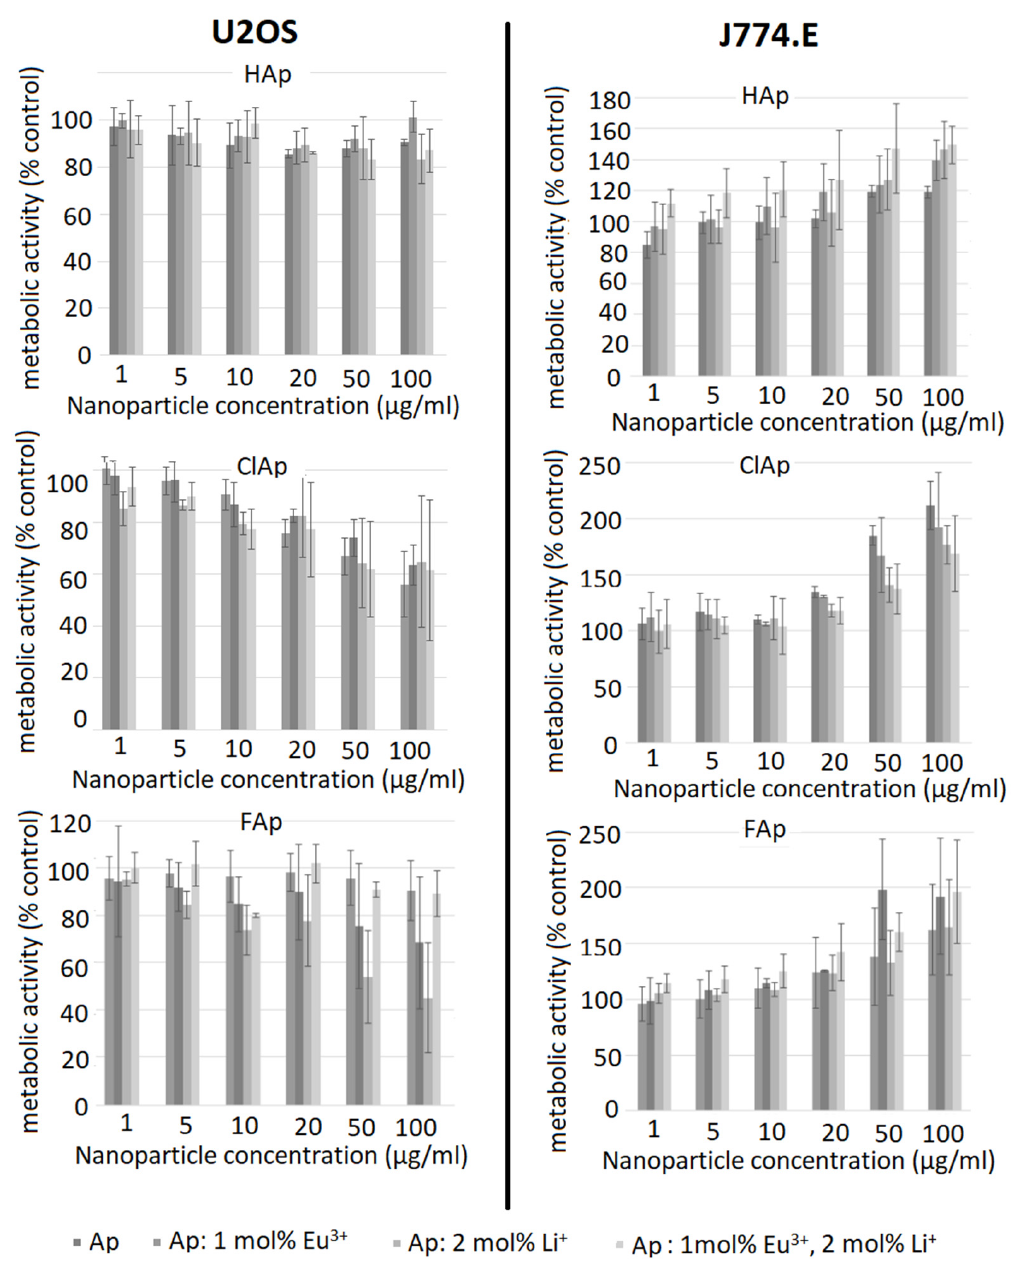
Figure 9. Influence of un-doped nanoapatites (Ap- HAp, ClAp, FAp) as well as nanoapatites doped and co-doped with Eu 3+ /Li + ions on metabolic activity of U2OS human osteosarcoma cells ( left panel ) and J774.E murine macrophages ( right panel ), determined by the MTT assay after 48 h exposure. A distinct concentration-dependent decrease in viability is seen in U2OS cells (Figure 10, left column). For the un-doped hydroxyapatite, cytotoxicity is observed at higher con- centrations (50 µg/mL) compared to all doped nanoparticle types. Anti-proliferative ef- fects of un-doped hydroxyapatite nanoparticles towards different cancer cell lines were described by several authors [59,60]. The mechanism involved is probably associated with particle internalization and subsequent apoptosis [61]. The effect of doping on the cyto- toxicity of the nanoapatites used in this study is variable and inconclusive, as no clear trends were identified. In a study by Karthi et al. [62], murine fibroblast cell line L929